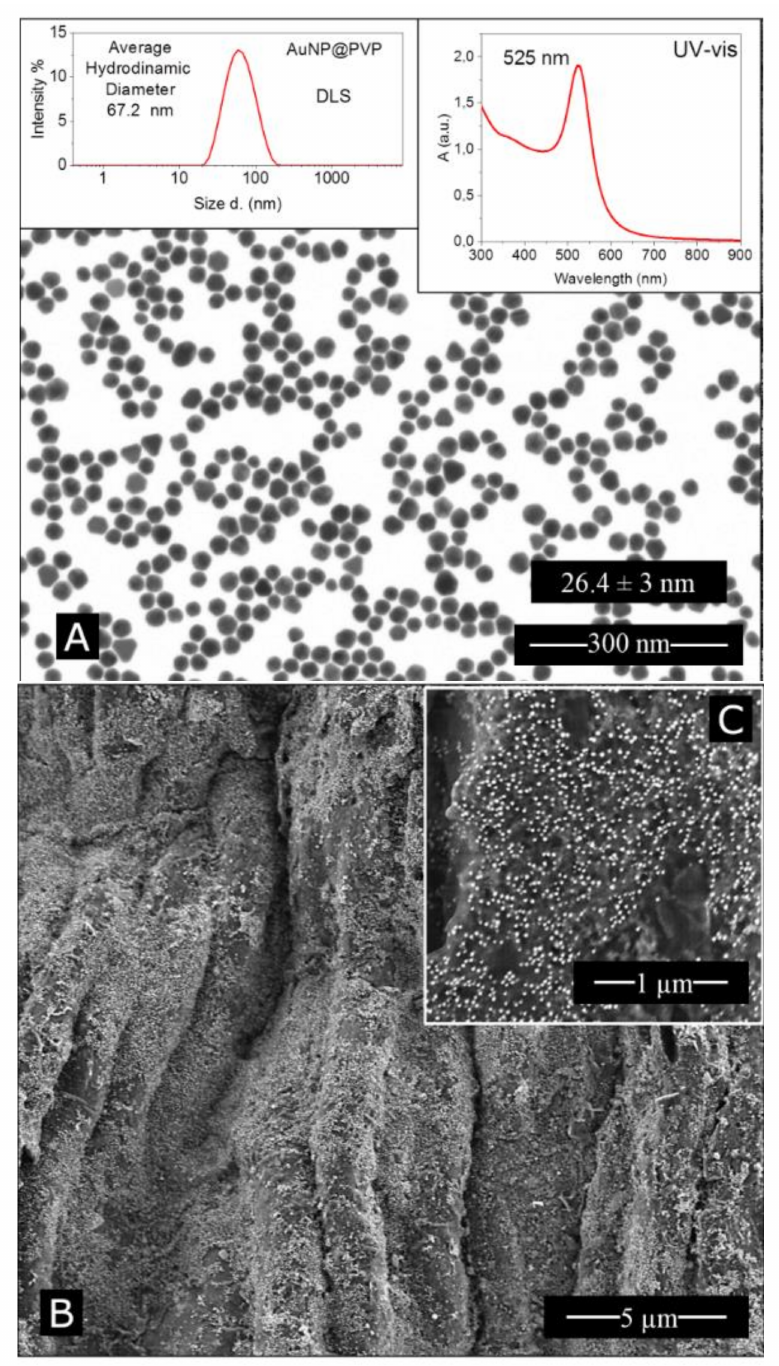
Figure A1. Polyvinylpyrrolidone coated Au NP physicochemical characterisation. ( A ) Bright field— scanning transmission electron microscopy (STEM); dynamic light scattering measurement of the Au NPs (Top left); UV–Vis spectra (Top right). ( B , C ) Scanning electron microscopy (SEM) of dried leaves covered with PVP Au